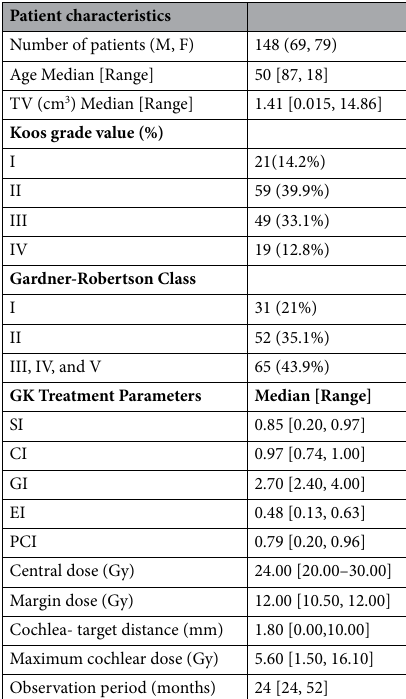
Table 4. The demographics information, clinical assessment parameters and dose plan indices of the patients included in the outcome